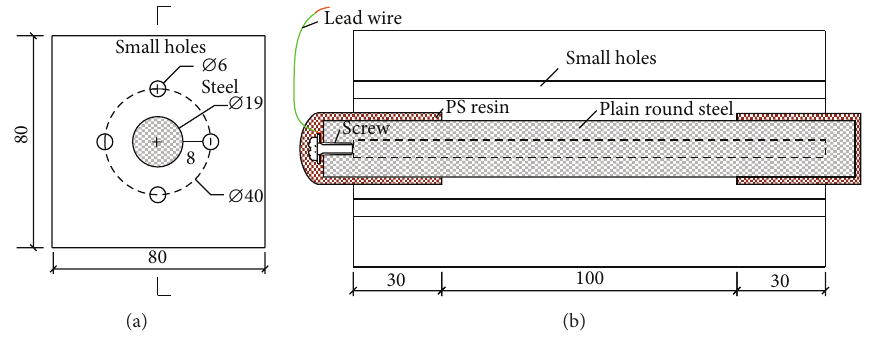
Figure 1: Schematic illustration of specimens used in this study (unit: mm).